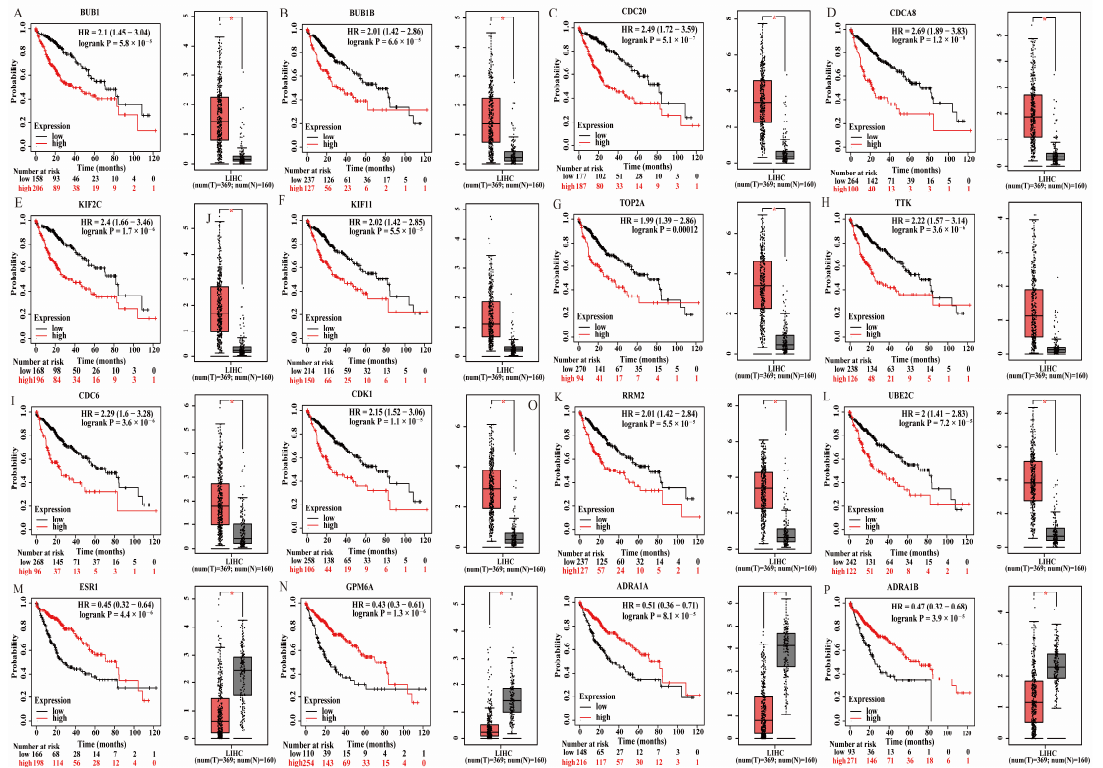
Figure 5. Screening the key genes in HCC. ( A – L ) Expression and prognostic values of BUB1 , BUB1B , CDC20 , CDCA8 , KIF2C , KIF11 , TOP2A , TTK , CDC6 , CDK1 , RRM2 , and UBE2C in HCC. ( M – P ) Ex ‐ pression and prognostic values of ESR1 , GPM6A , ADRA1A , and ADRA1B .